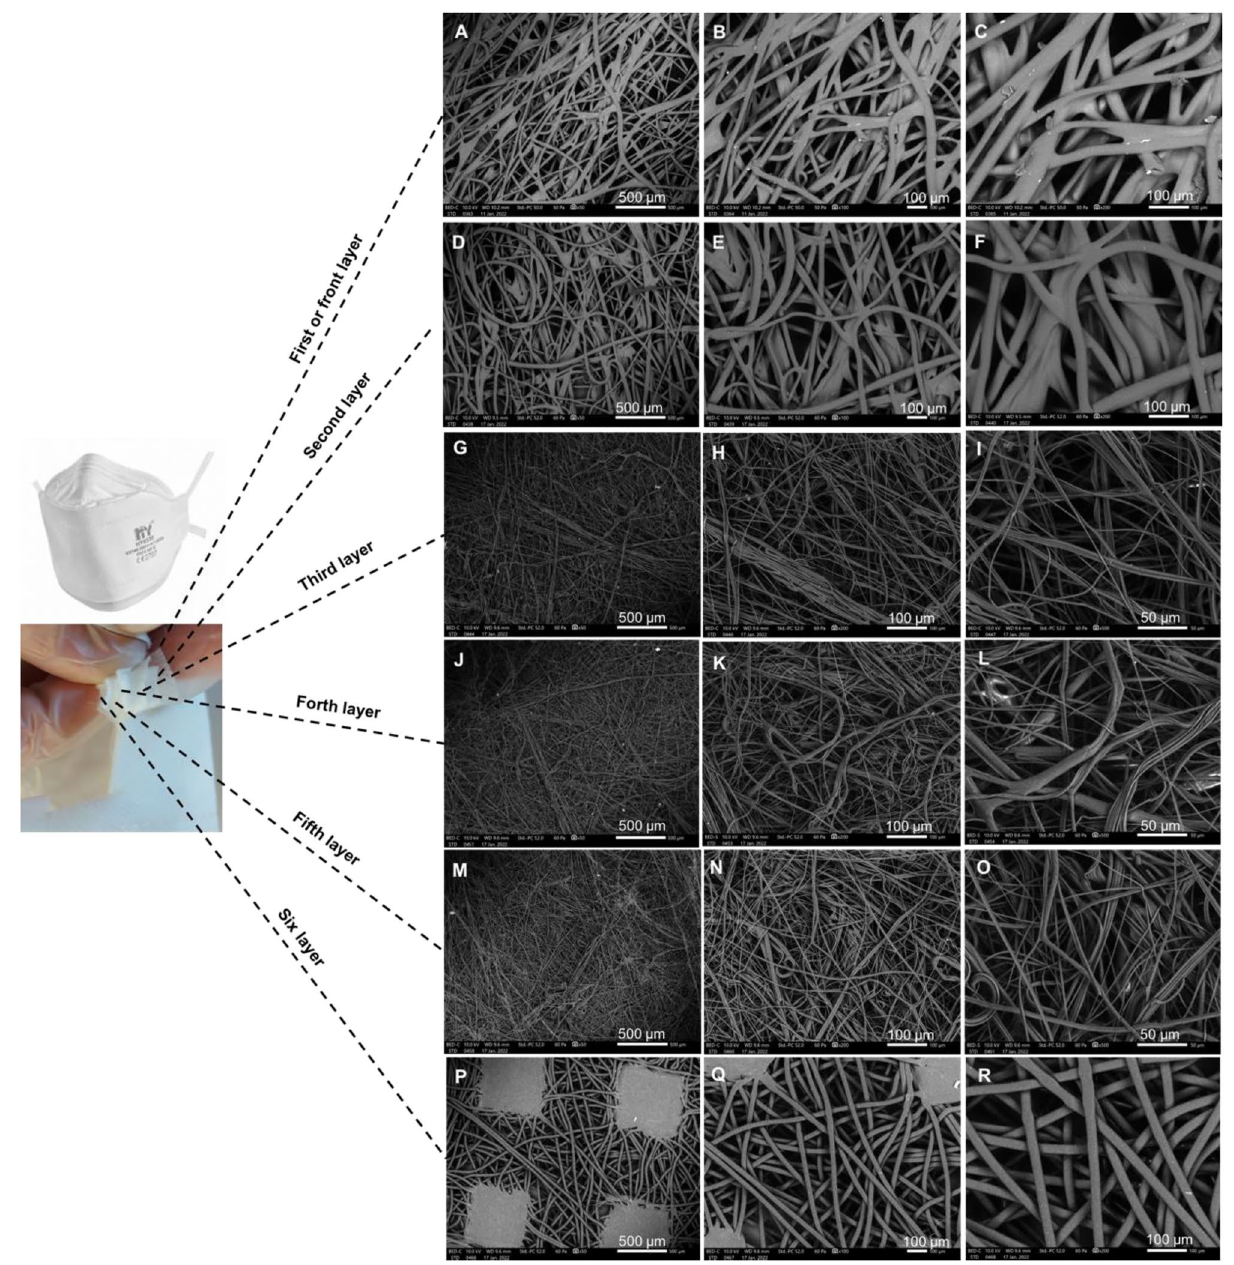
Figure 4. SEM for each of the six layers of a FFP3 face mask. ( A – C ) front layer. ( D – F ) second layer. ( G – I ) third layer. ( J – L ) forth layer. ( M – O ) fifth layer. ( P – R ) six